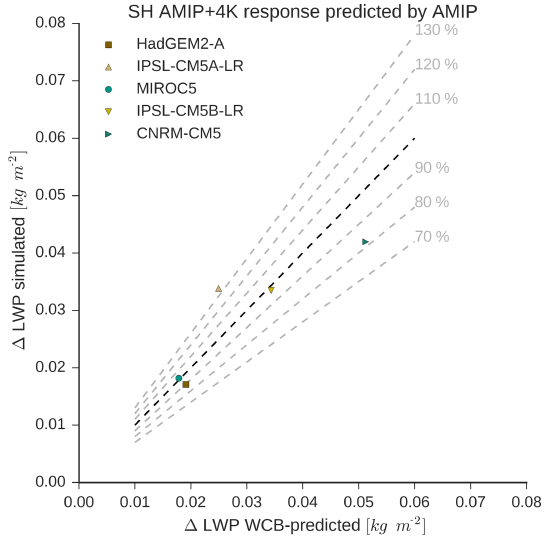
Figure 8. The difference in cyclone LWP in the SH between AMIP and AMIP + 4K simulations versus the difference in SH cyclone LWP inferred from changes in the WCB moisture flux and the rela- tionship between the WCB moisture flux and LWP CM in the current climate. The 1-to-1 line is shown as a dark dashed